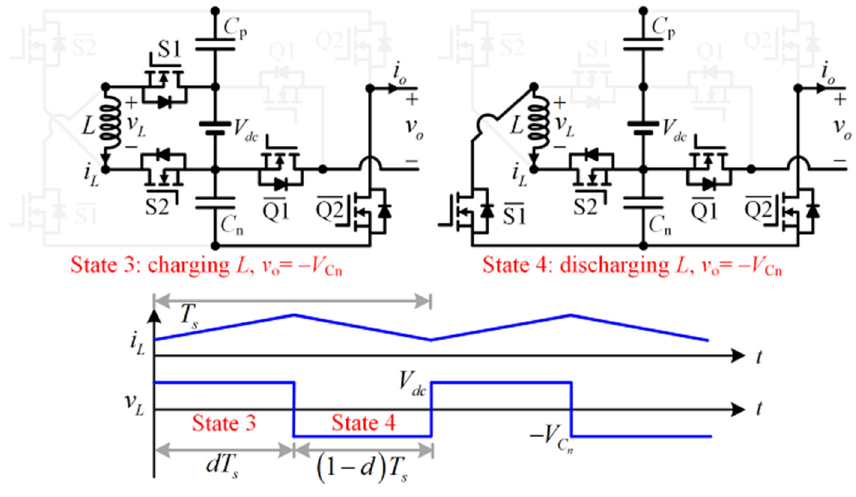
Figure 3. Switching states and key waveforms of the universal converter operating in mode 2 for generating a negative dc voltage.